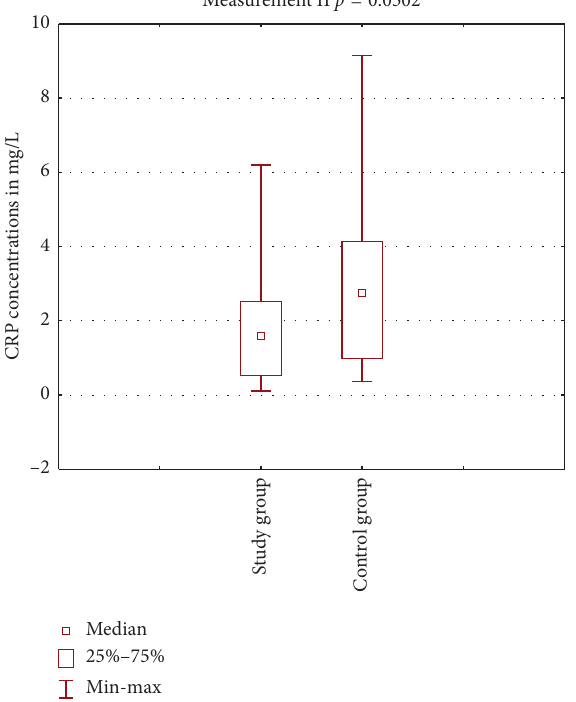
Figure 4: Analysis of the results of measurements in both groups—measurement II.